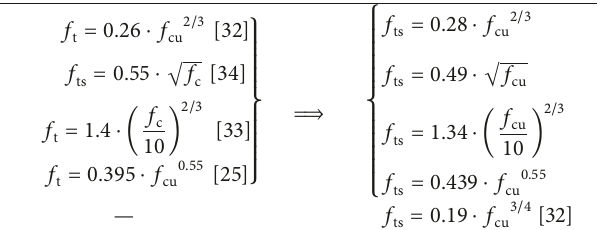
Table 3: Compressive-tensile relationship. 2/3 [32] 𝑓 = 0.26 ⋅ 𝑓 t cu 𝑓 = 0.55 ⋅ √𝑓 [34] ts c